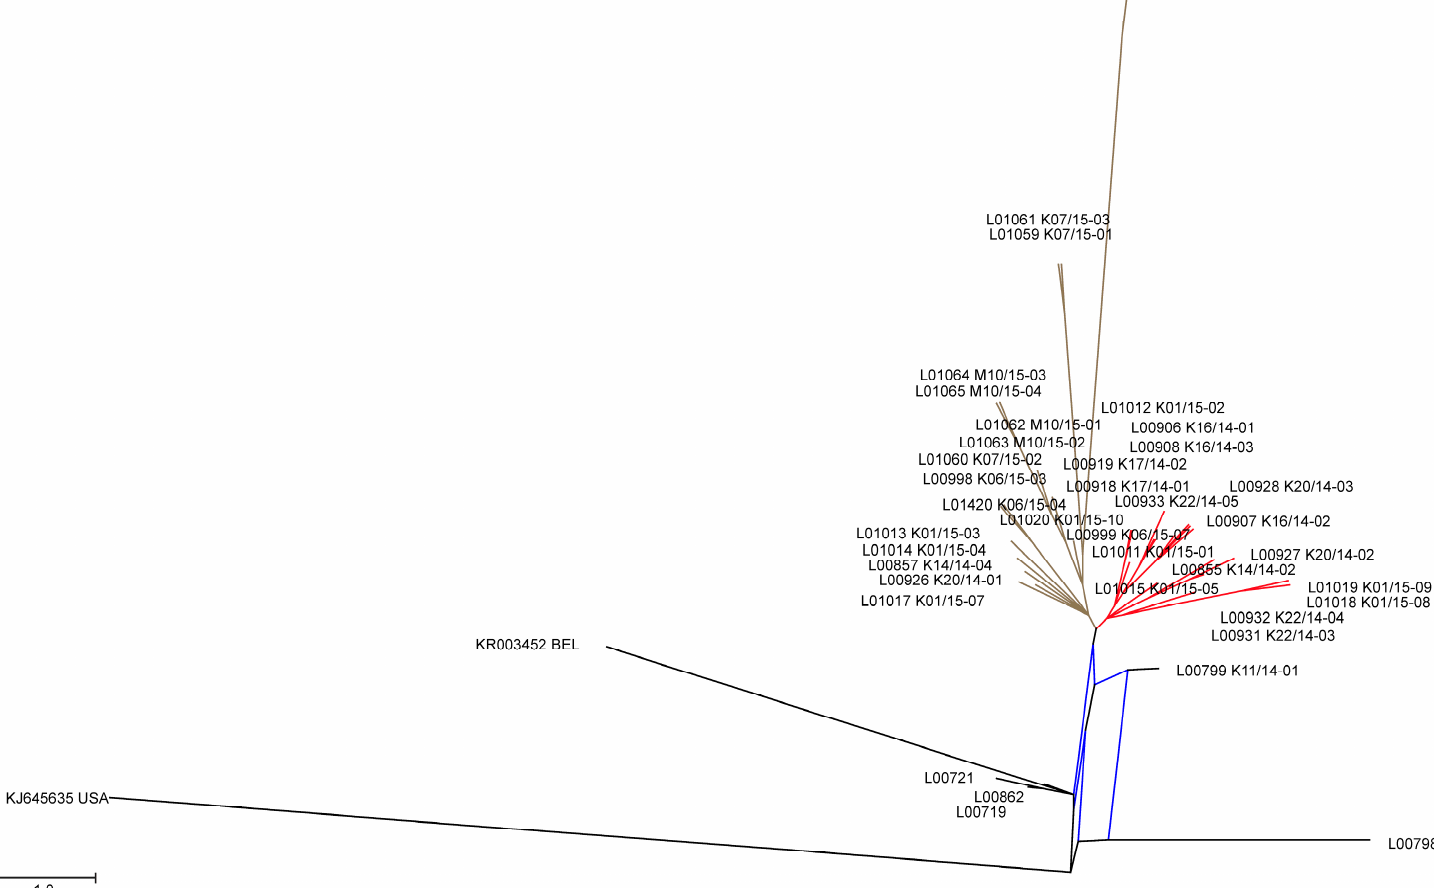
Figure 2. Network Tree generated by parsimony splits with SplitsTree [23] from the European samples of this study using KJ645635 USA as outgroup. The red colored branches show cluster 1, and walnut colored branches cluster 2, respectively. Cluster 3 can be found at the left bottom of the graph (black).